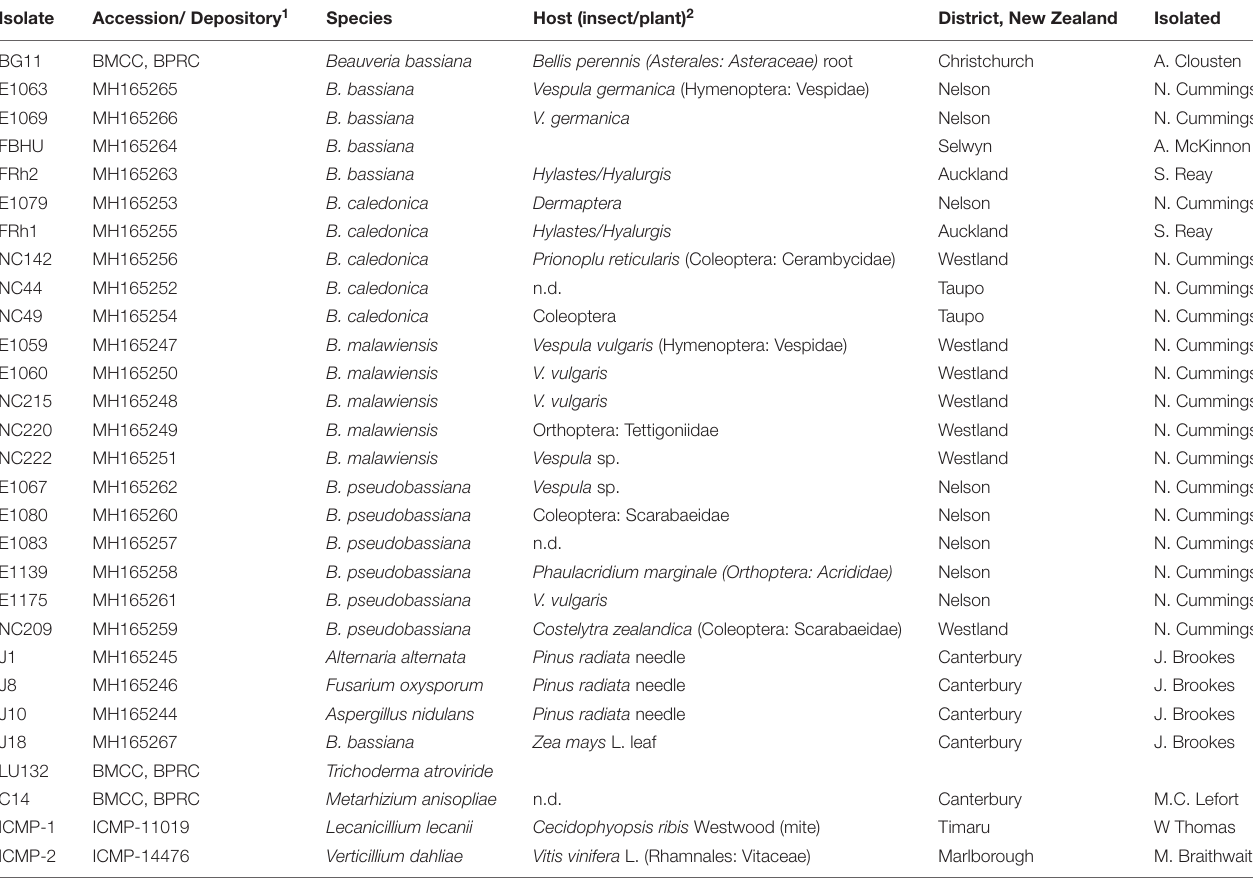
TABLE 1 | Table of fungal isolates used in this